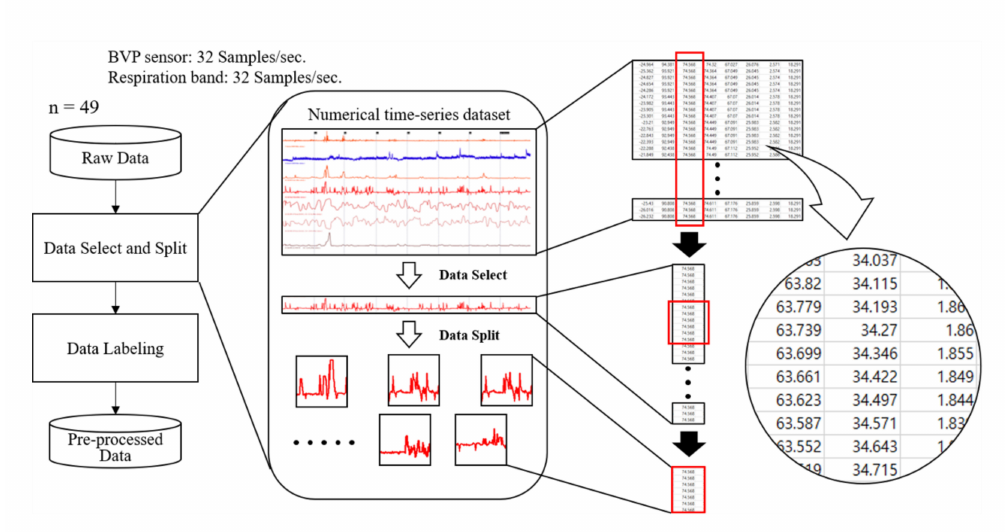
Figure 4. Data pre-processing procedure.